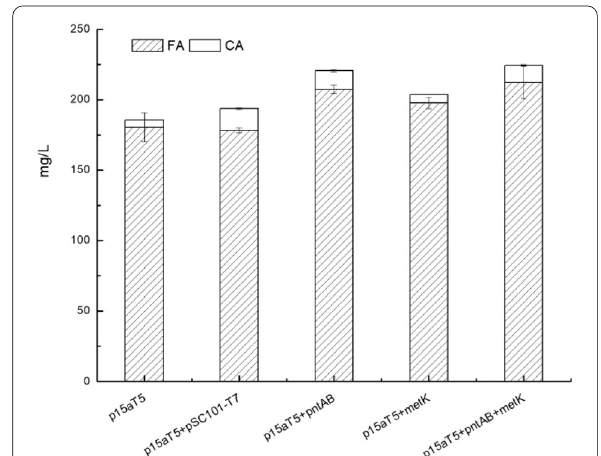
Fig. 5 Effect of combination of NADPH regenerating enzyme gntAB with S -adenosyl- L -methionine synthetase metK in